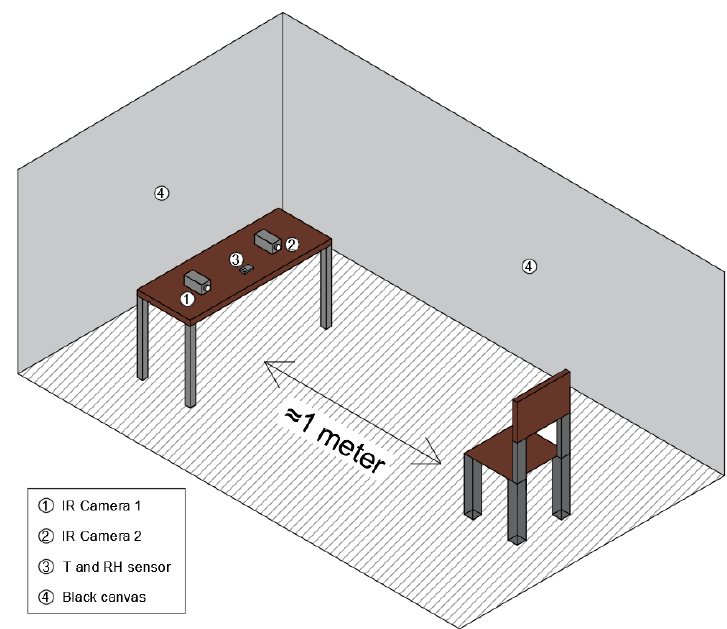
Figure 1. Schematic representation of the setup inside the climatic chamber.